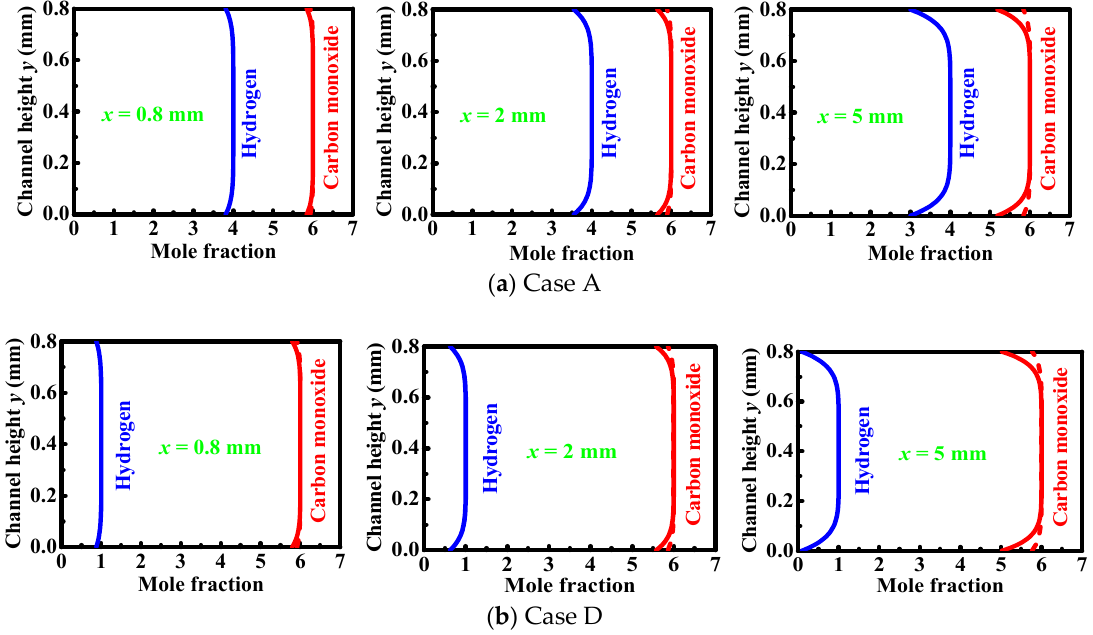
Figure 10. Transverse profiles of carbon monoxide and hydrogen mole fractions for Cases A and D at a constant surface temperature of 500 K.